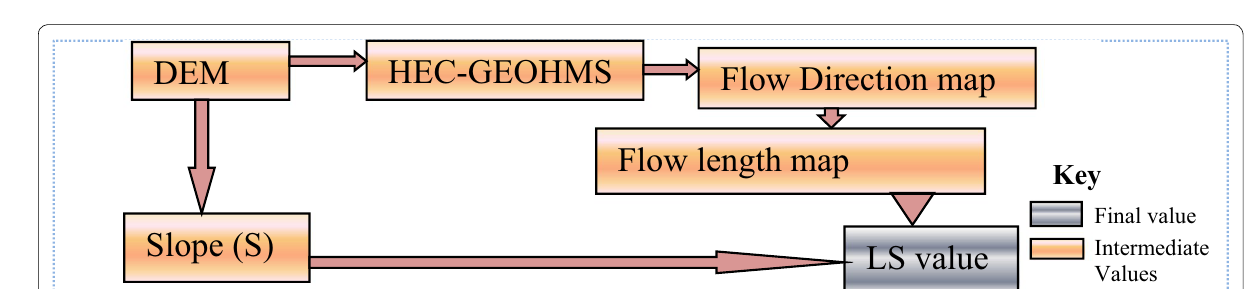
Fig. 8 Flow chart for LS value determination